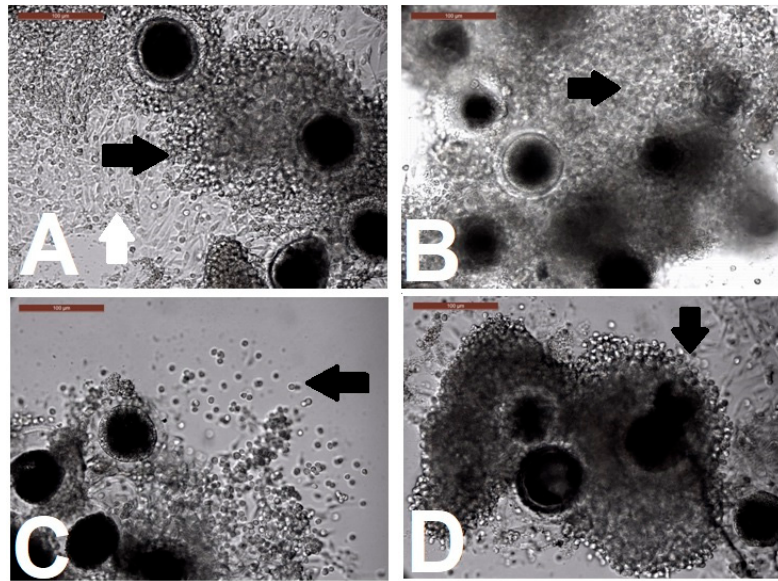
Figure 2. Different degrees of cumulus expansion after biphasic in vitro maturation with ROCK-inhibitor supplementation pre-IVM. ( A , B , D ) display partial expansion, grade 1 for control, 2RI, and 6RI biphasic IVM, respectively. ( C ) shows full cumulus expansion, grade 2, observed in the 4RI biphasic IVM group. Arrows show the transparency of intercellular spaces between the cumulus cells. The white arrow in A shows the compactness of cumulus cells after biphasic IVM. The arrow in C shows the fully expanded corona radiata, the innermost part of the cumulus cell. Scale bar = 100 μ m.